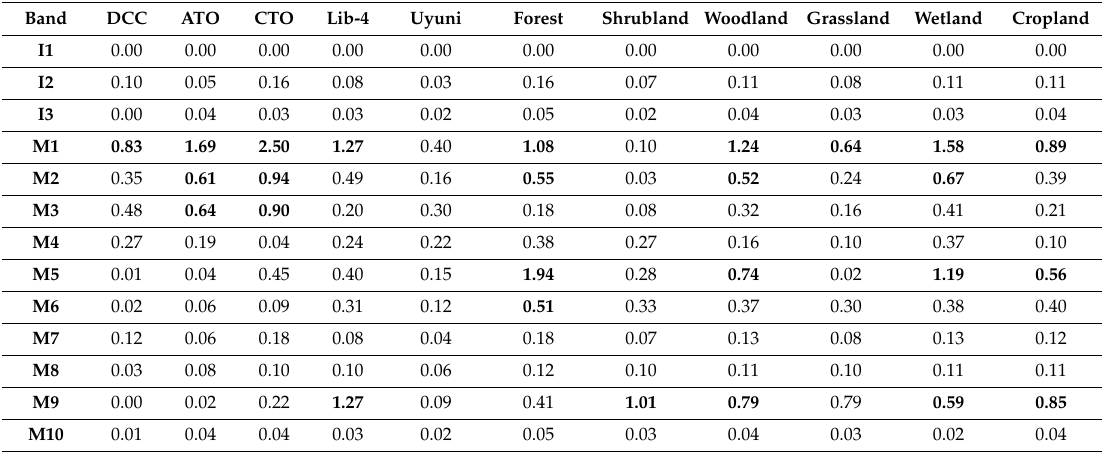
Table 4. S-NPP VIIRS GT RSR Earth-reflected scene-dependent γ for measured 1% extended bandpass limits, shown in %.